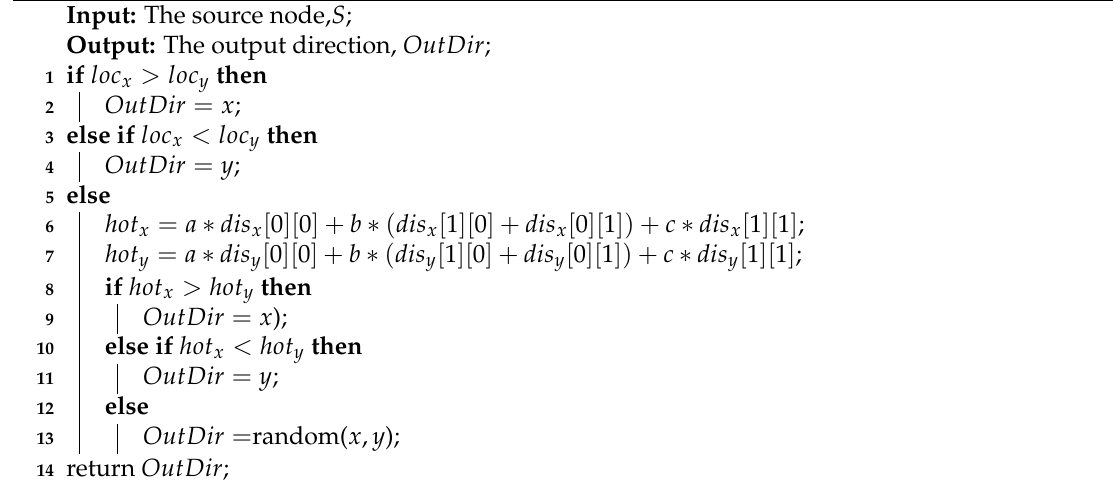
Algorithm 2: Routing algorithm for nodes in the central